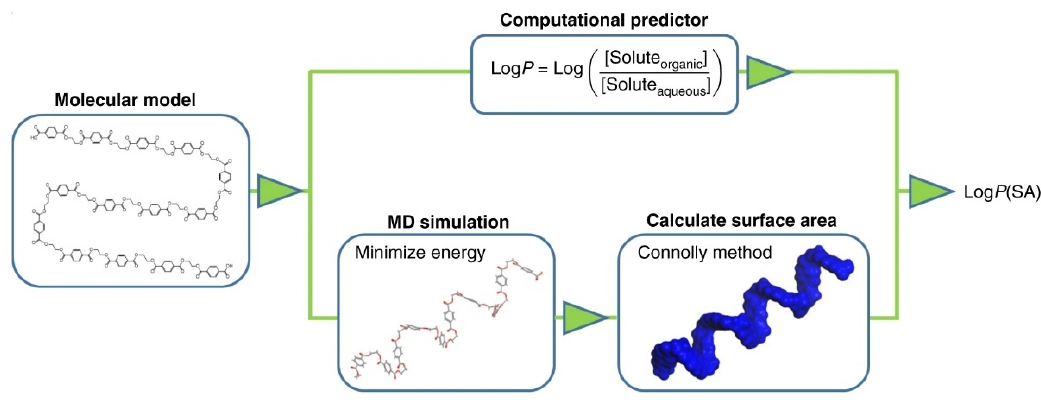
Figure 12. Flow chart for calculating hydrophobicity [62].